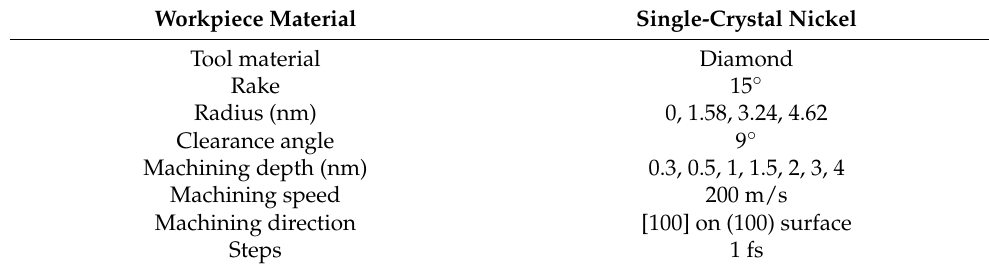
Table 1. MD Simulation parameters of nanomachining.